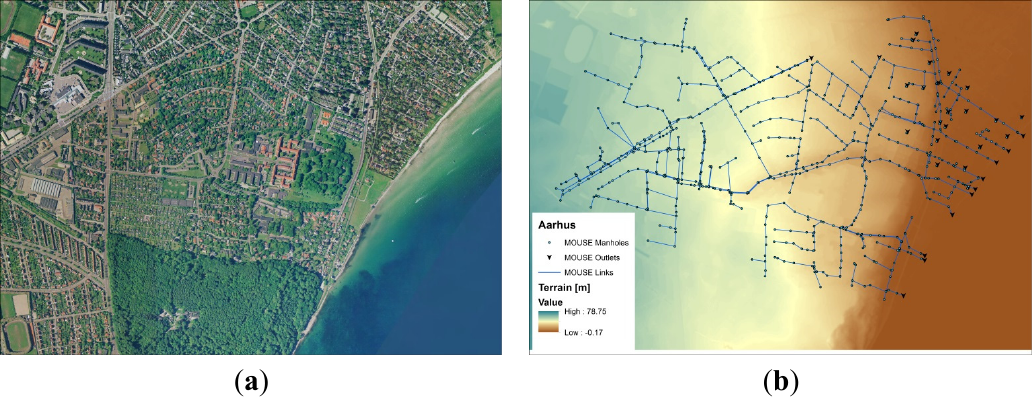
Figure 7. Study area located in Aarhus, Denmark. The area is a fully developed residential area with a combined sewer system. ( a ) shows an orthophoto while ( b ) shows the digital surface terrain as well as the sewer